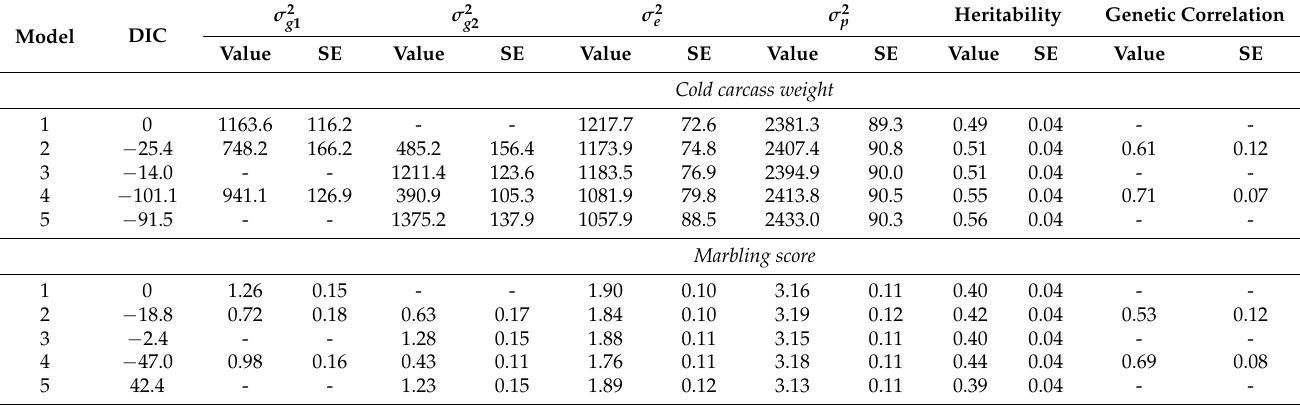
Table 2. Deviance information criterion (DIC) and the estimated parameters and their standard errors (SEs) 1